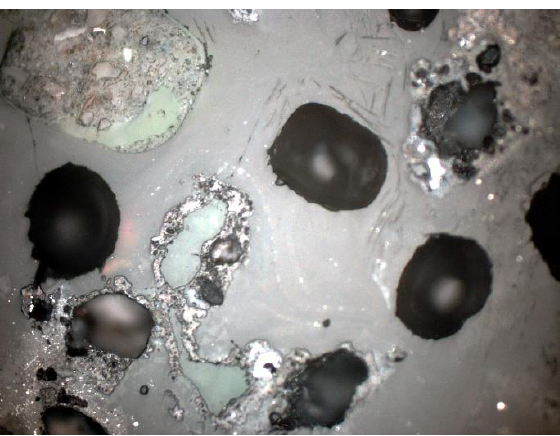
Figure 27. Closed pores visible under a petrographic microscope, SP1 sample, polished section, 1P, 100×, reflected light.